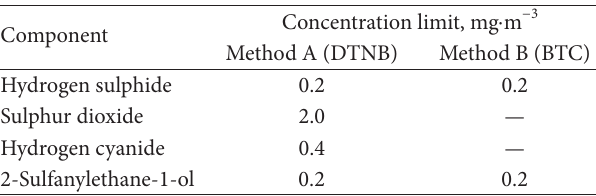
T 3: Concentration limit of foreign components which with reagents produce coloured